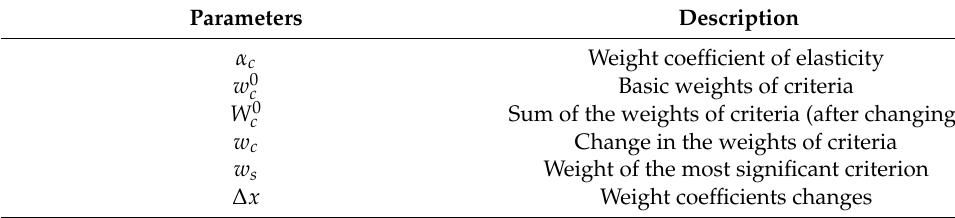
Table 9. Alternative class types.